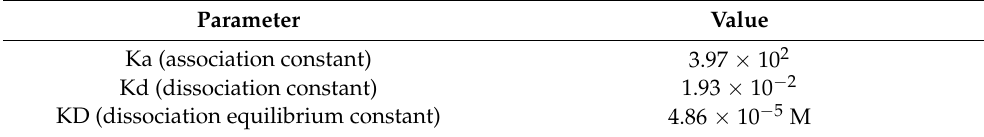
Figure 2. Ex vivo data on the interaction of RSV with HbA. ( A ) SPR assay results for RSV and HbA. The X-axis is time, and the Y-axis is resonance unit (RU). ( B ) Spectra of HbA with RSV over 4 h of deoxygenation. ( C ) Potential small-molecule binding pockets of the hemoglobin tetramer. In the protein structure, the hemoglobin α subunit homodimer is shown in red, the hemoglobin β subunit homodimer is shown in blue, and heme is shown in green. Small-molecule binding pockets were indicated by ellipses. ( D ) Hemoglobin/RSV complex. The tetramer is shown as a red and blue ribbon, and RSV is shown in green. ( E ) Resveratrol binding area and the contact amino acids (several amino acids are hidden for display convenience). ( F ) The molecular surface of the interaction region (red is the negatively charged region, blue is the positively charged region, and gray is the hydrophobic region). The amino acid V63 forms a Π -hydrogen bond with RSV. ( G ) Tm of HbA and HbA with RSV. Note: **, vs. HbA, p < 0.01; ##, vs. HbA: RSV = 1:1, p < 0.01. Table 1. Ka, Kd, and KD values of HbA and RSV calculated using SPR assays.